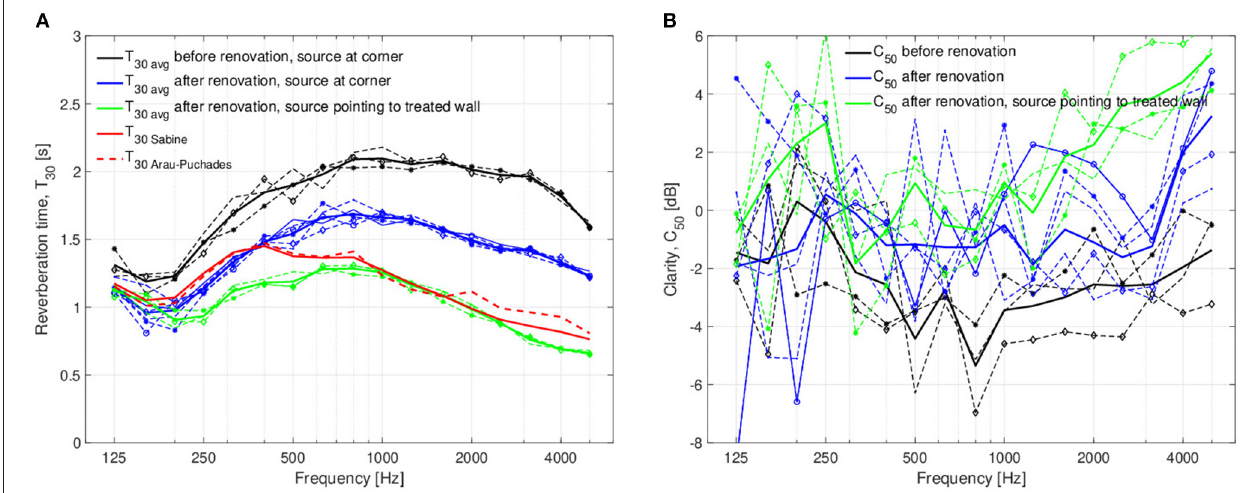
FIGURE 8 | Measurement results of T 30 (A) and C 50 (B) before and after the installation of acoustic treatment in the historical room in the Supreme Court. Reverberation time predictions according to Sabine’s and Arau-Puchades theories are included in (A)